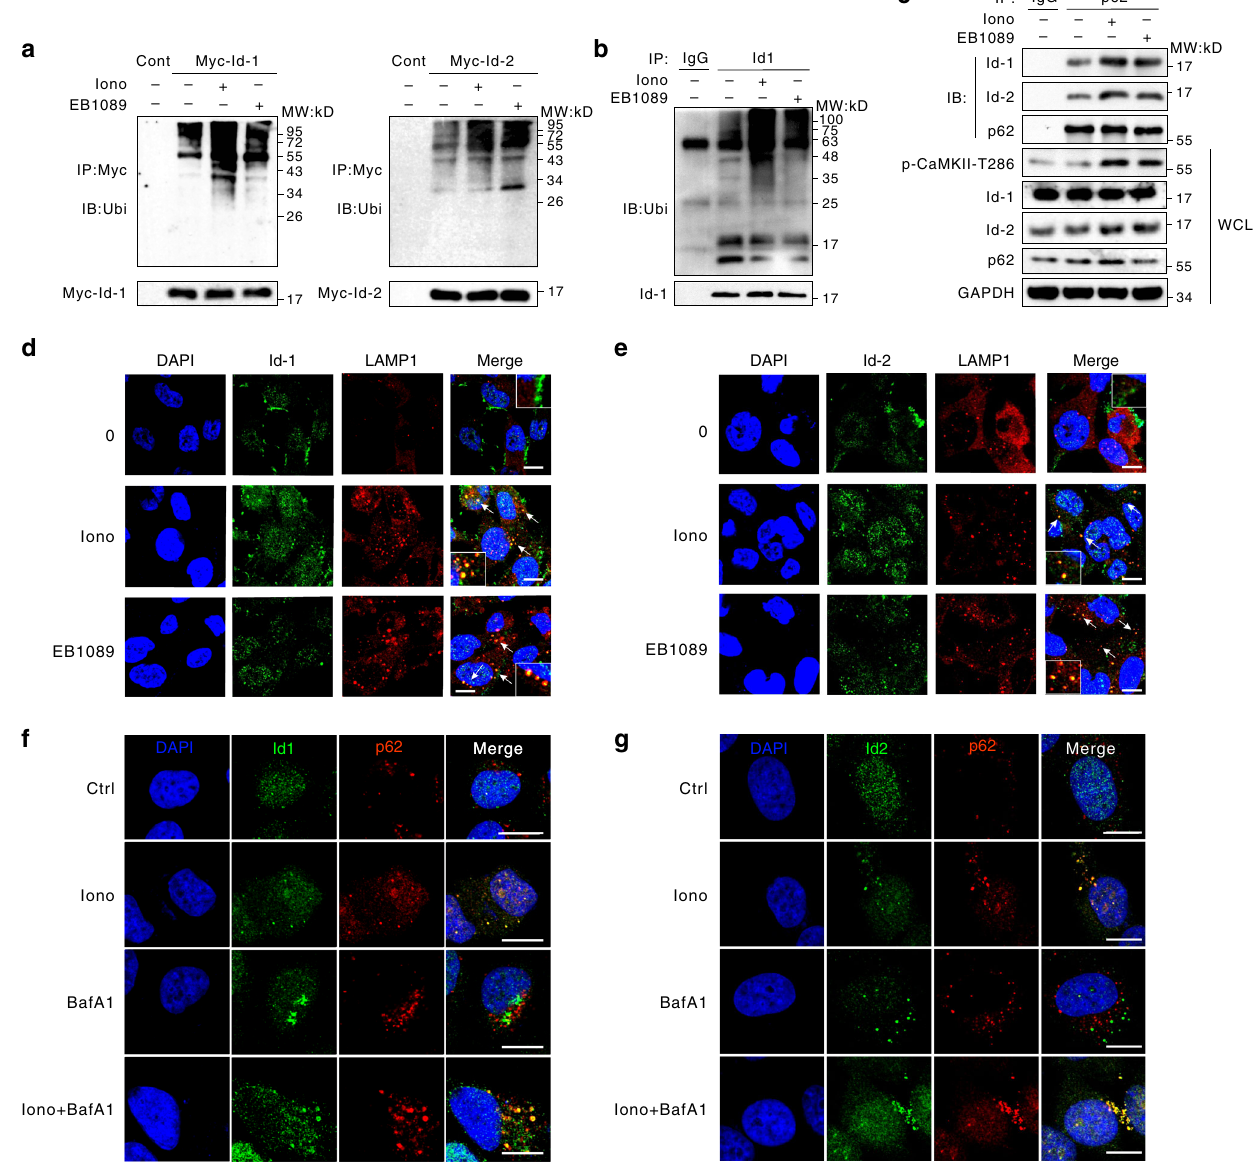
Fig. 5 The Lys-63-linked ubiquitylation of inhibitor of differentiation proteins are essential to their autophagic degradation. a Ionomycin and EB1089 enhanced Id-1/2 ubiquitination. HEK293T cells were transiently transfected with the indicated plasmids, treated with 6 μ M ionomycin or 100 nM EB1089 for 24 h, and then incubated in 100 nM Baf A1 for 4 h. Immunoprecipitated Myc-Id-1/2 was subjected to anti-ubiquitin western blotting. b Ionomycin and EB1089 enhanced endogenous Id-1 ubiquitination. SK-N-SH cells were treated with 6 μ M ionomycin or 100 nM EB1089 for 24 h, and then incubated in 100 nM Baf A1 for 4 h. Immunoprecipitated Id-1 was subjected to anti-ubiquitin western blotting. c Id-1 and Id-2 interact with p62. HEK293T cells treated with 6 μ M ionomycin or 100 nM EB1089 for 24 h and 100 nM Baf A1 for 6 h before collect. The protein extracts were incubated with anti-p62 or normal mouse IgG antibodies prior to western blot. The resulting immunoprecipitates (IP) were subjected to western blot analysis using the indicated antibodies. WCL, whole-cell lysate. d Id-1 was enclosed in LAMP1-positive autolysosomes. MEFs cells were transiently transfected with Myc-Id-1 and then incubated with 6 μ M ionomycin or 100 nM EB1089 for 24 h. Confocal images of transfected cells representing the co-localization of Id-1 with the lysosome marker LAMP1. The merged images and relative insets reveal the co-localization. Scale bar, 10 μ m. e Id-2 was enclosed in LAMP1-positive autolysosomes. MEFs cells were transiently transfected with Myc-Id-2, then incubated with 6 μ M ionomycin or 100 nM EB1089 for 24 h. Confocal images of transfected cells representing the co-localization of Id-2 with the lysosome marker LAMP1. The merged images and relative insets reveal the co-localization. Scale bar, 10 μ m. f , g Id-1 and Id-2 was recruited by p62. MEFs cells were incubated with 6 μ M ionomycin for 24 h and Baf A1 for 2 h. Confocal images of cells representing the co- localization of Id-1/2 with p62. The yellow puncta of the merged images reveal the co-localization. Scale bar, 10 μ